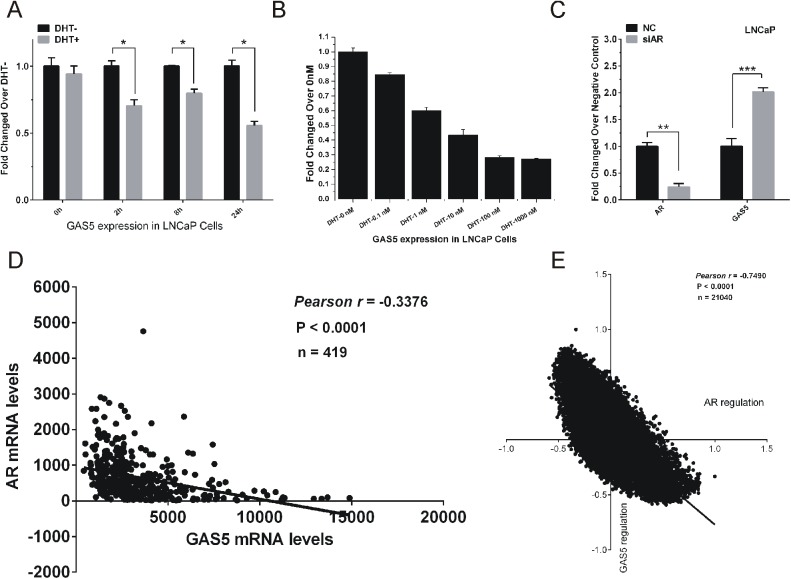
The regulation of AR on the expression of LncRNA GAS5.(A) qRT-PCR analysis of GAS5’s expression in LNCaP cells treated with DHT in time series of 0h, 2h, 8h, 24h, 48h. (B) qRT-PCR analysis of GAS5’s expression in LNCaP cells treated with DHT in dose series of 0nM, 0.1nM, 1nM, 10nM, 100nM, 1000nM. (C) The efficiency of siAR on the expression of AR was confirmed by qRT-PCR and the expression of GAS5 was tested after transfection of siAR compared with NC in LNCaP cells. (D) The correlation of mRNA level between GAS5 and AR. (E) The correlation of regulation between GAS5 and AR. Significance was defined as p < 0.05 (*p < 0.05; **p < 0.01; ***p < 0.001).